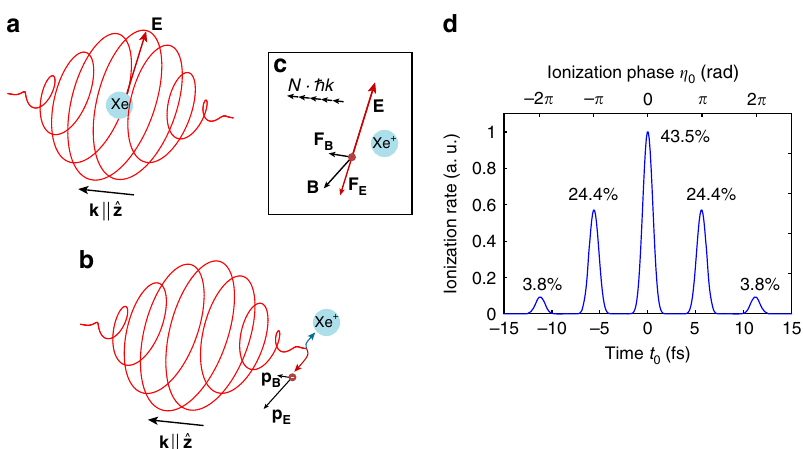
Fig. 1 Timing of linear momentum transfer probed with the attoclock method. The rotating electric fi eld vector serves as a time reference to clock the linear momentum transfer onto the electron. a The xenon atom at the time of ionization when the electric fi eld is maximal. b The electron after the pulse has passed. The electron leaves the pulse at an angle of (cid:4) 90 (cid:9) ð¼ π = 2 Þ with respect to the electric fi eld vector at the time of ionization. Deviations from this angle are caused by the in fl uence of the parent-ion interaction and ionization delay times. c Illustration of the forces acting on the outgoing electron after it was released from the ion. The magnetic fi eld component of the laser fi eld is responsible for a force in laser beam propagation direction. This force can be understood in terms of transfer of linear photon momentum onto the outgoing electron. d Ionization rate based on the ADK-theory 36 during the pulse as function of the ionization phase η as well as the time t 0 0